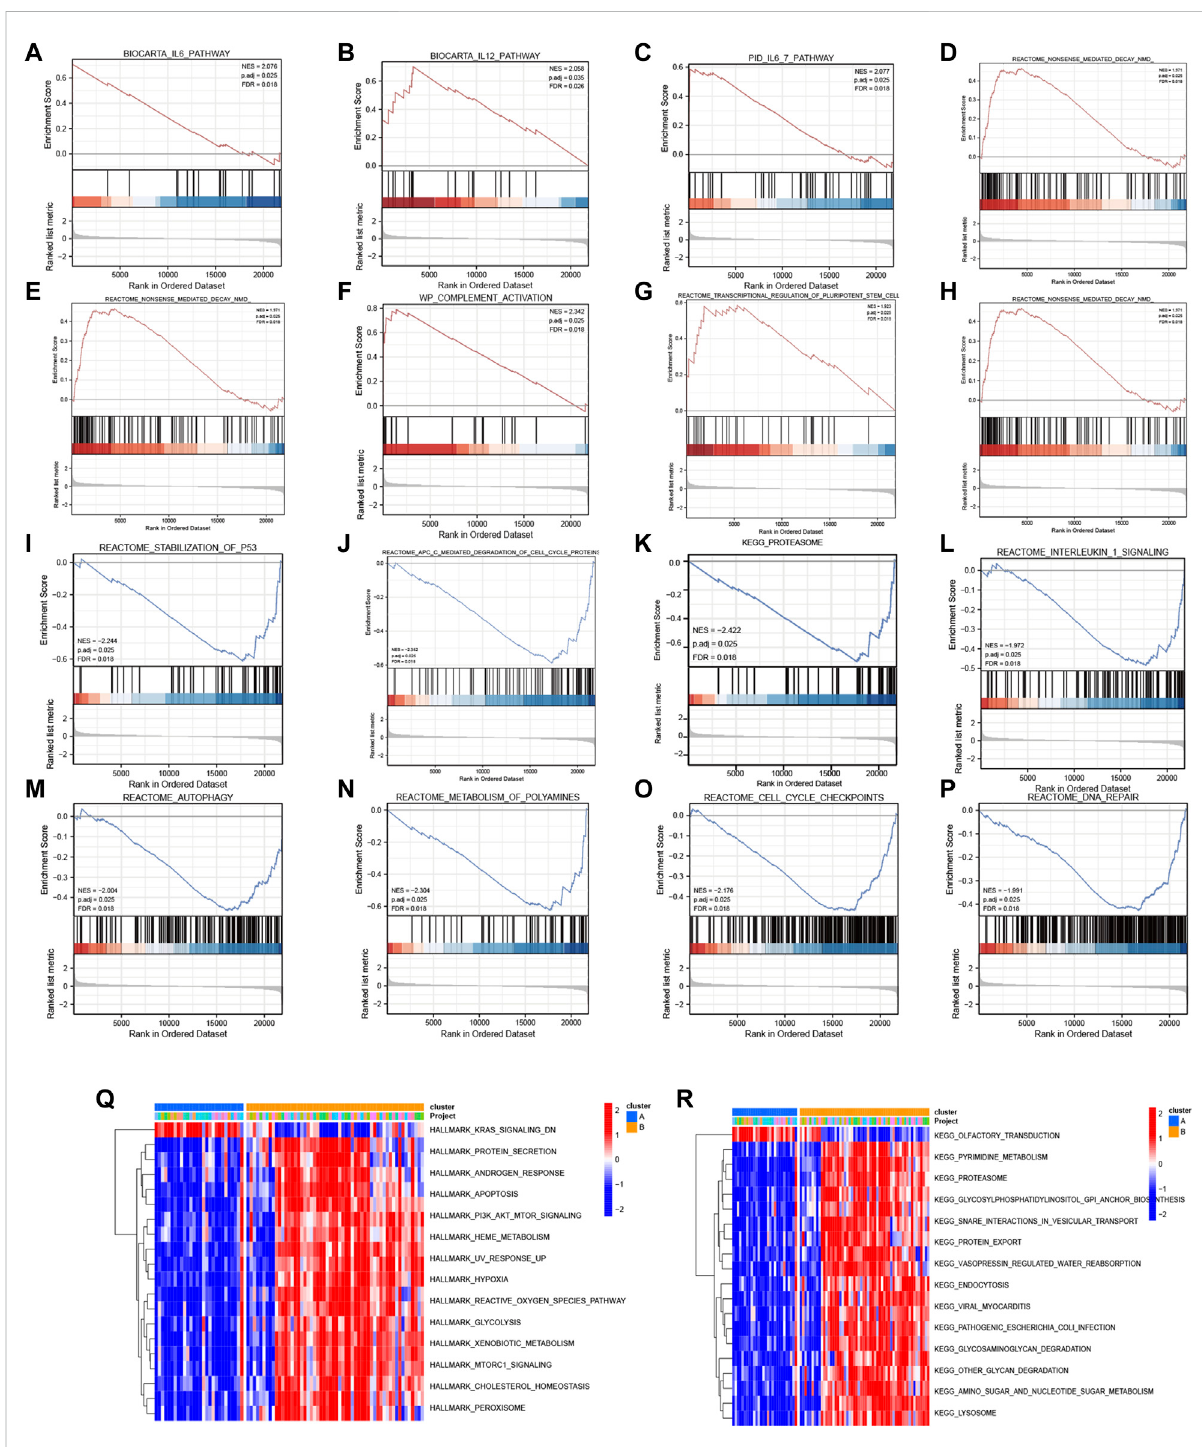
FIGURE 8 GSEA and GSVA. GSEA results: KEGG pathways with signi fi cantly differential enrichment between patients with (A – H) high and (I – P) low expression of the four diagnostic genes. GSVA results: (Q) Hallmark and (R) KEGG pathways with signi fi cantly differential enrichment between mitochondrial dysfunction-related clusters A and